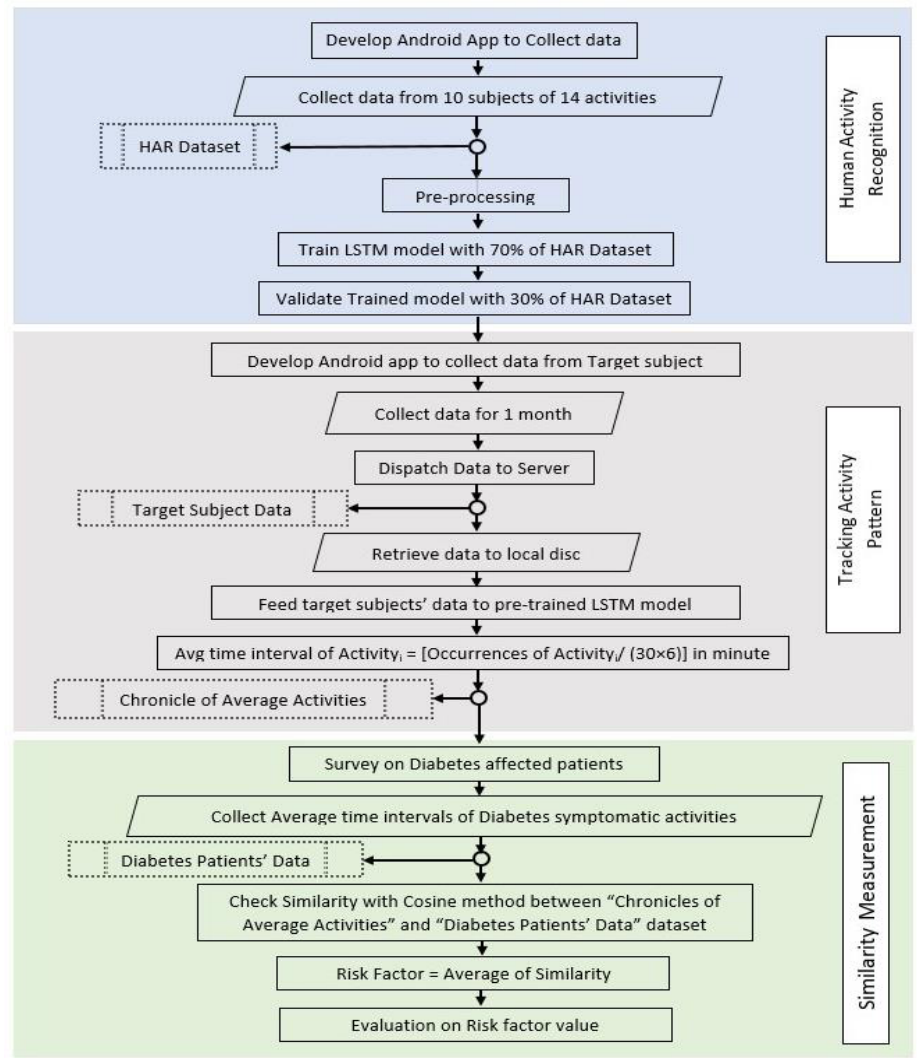
Figure 1. Flowchart depicting the proposed methodology.